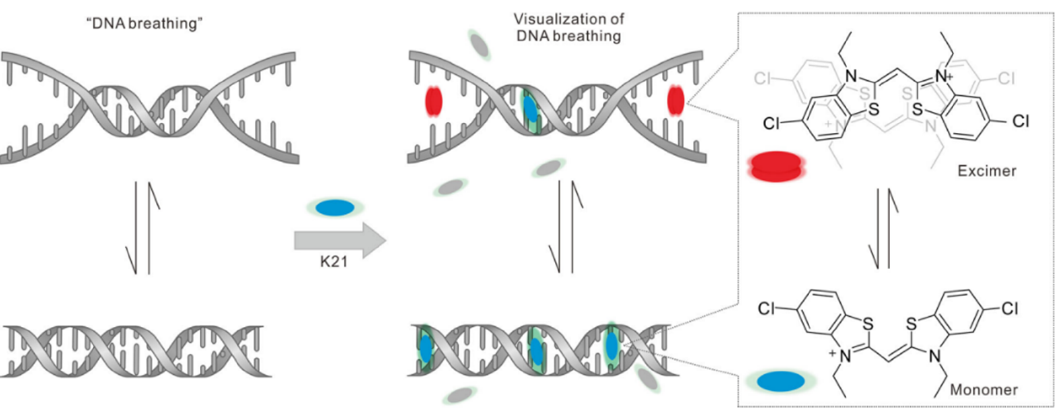
Figure 18. Illustration of proposed binding mechanism between K21 dye and dsDNA. Reproduced from [65] with permission from John Wiley and Sons, Copyright 2021.